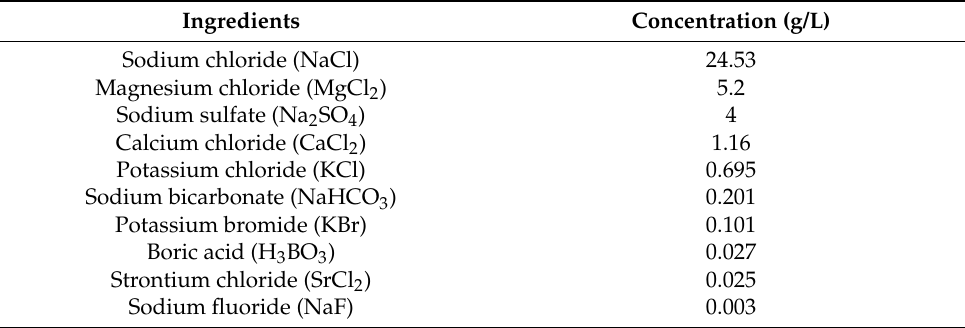
Table 4. Chemical composition of artificial seawater